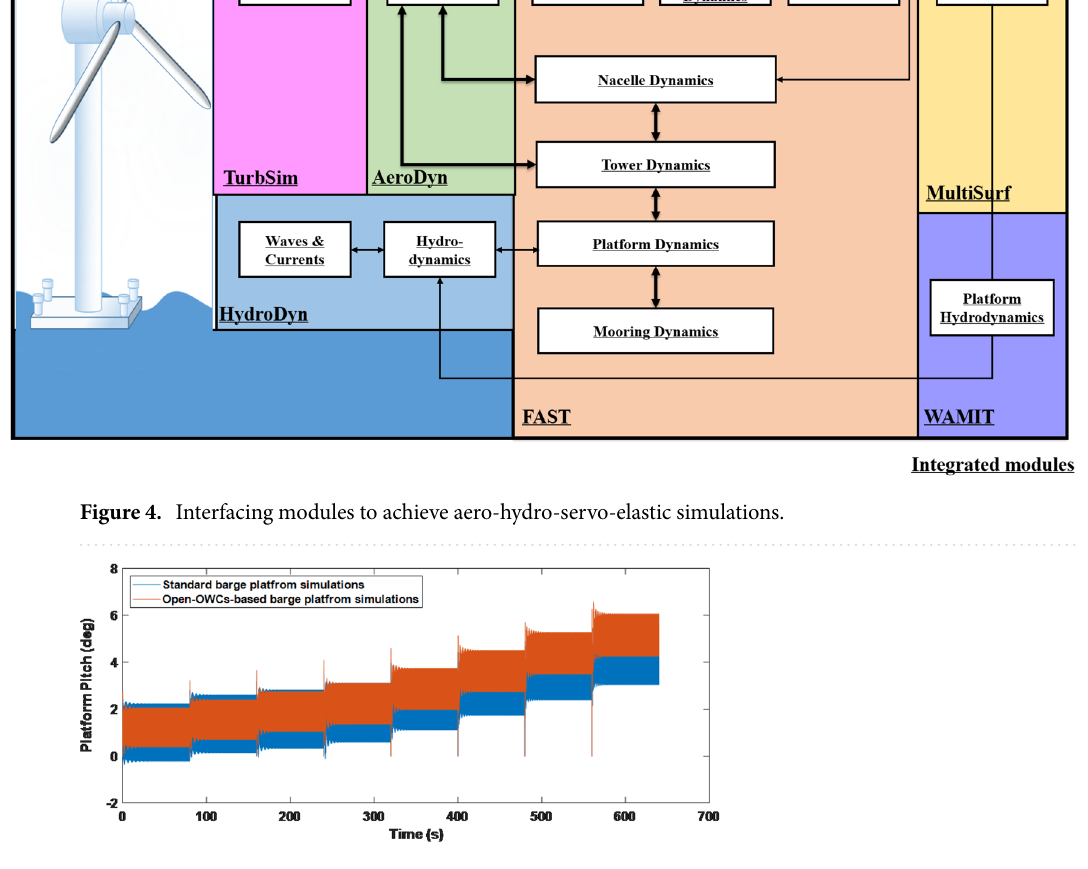
Figure 5. Standard based Barge Platform and 4-OWCs-based Barge Platform